Question: Sum up the contents of this chart in one sentence.
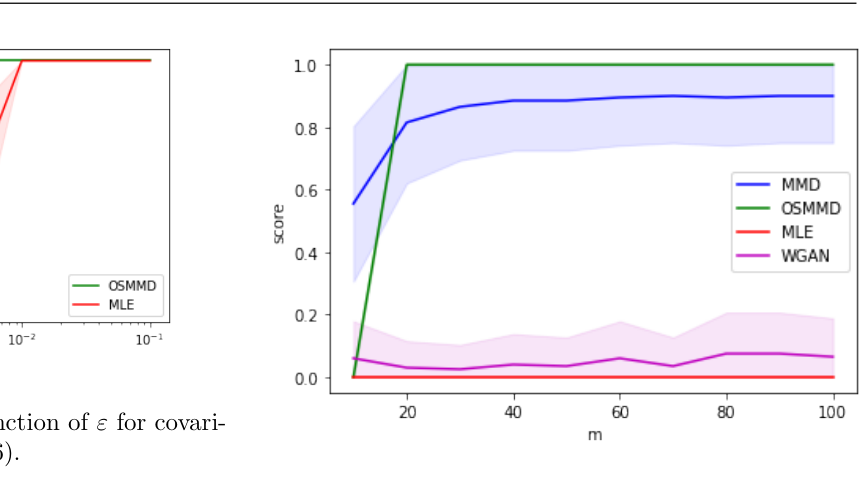
Answer: Success rate in a 2-GMM model with un- known covariance as a function of m.